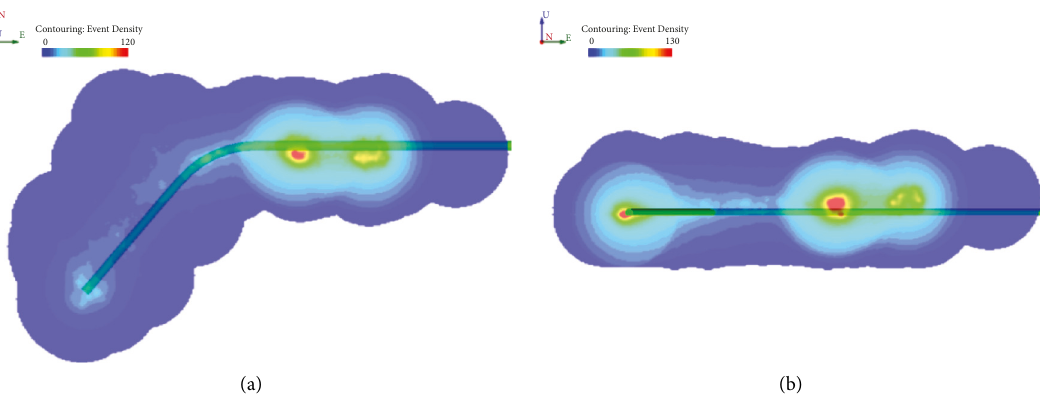
Figure 13: Density cloud chart of microseismic events in the traffic tunnel. (a) Planform. (b) Left